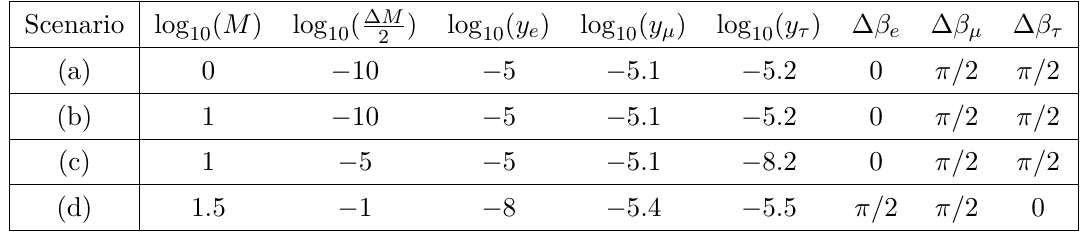
Table 2 . Input parameters for the comparison between the analytical and numerical solutions shown in figure 7. The perturbative y 0 parameters are always taken to be the same: y 0 10 − 9 . 1 , y 0 = 10 − 9 . 2 τ